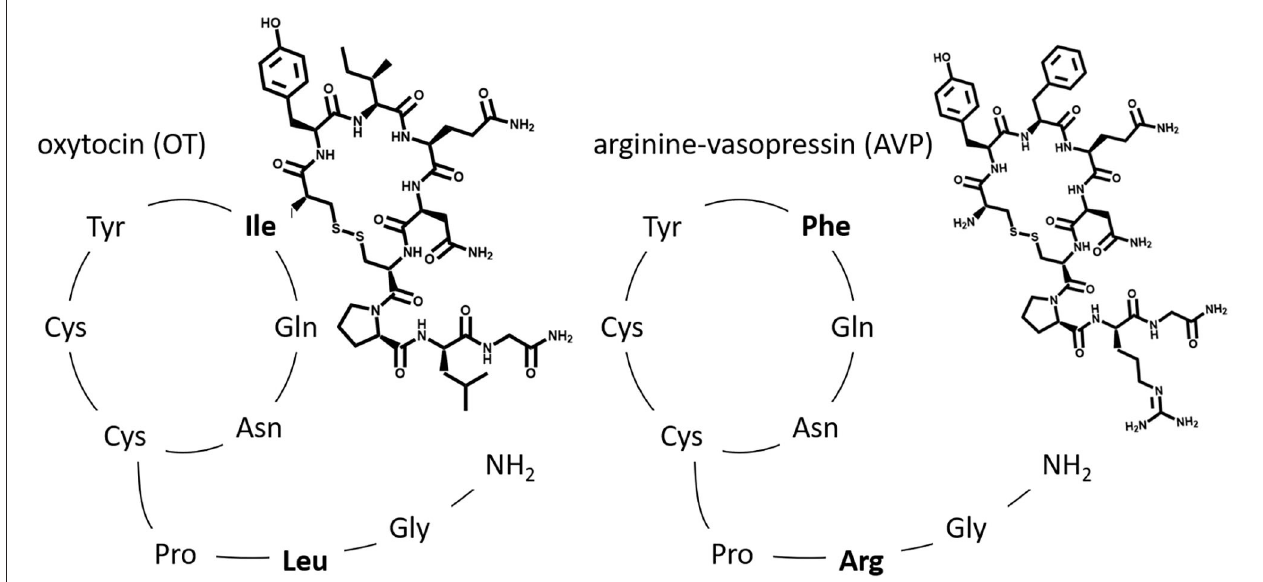
FIGURE 2 | Original: The relative amino acid sequence of the two posterior pituitary nonapeptides, oxytocin (OT) and arginine vasopressin (AVP). Highlighted are the two differing amino acids found in the 3rd and 8th